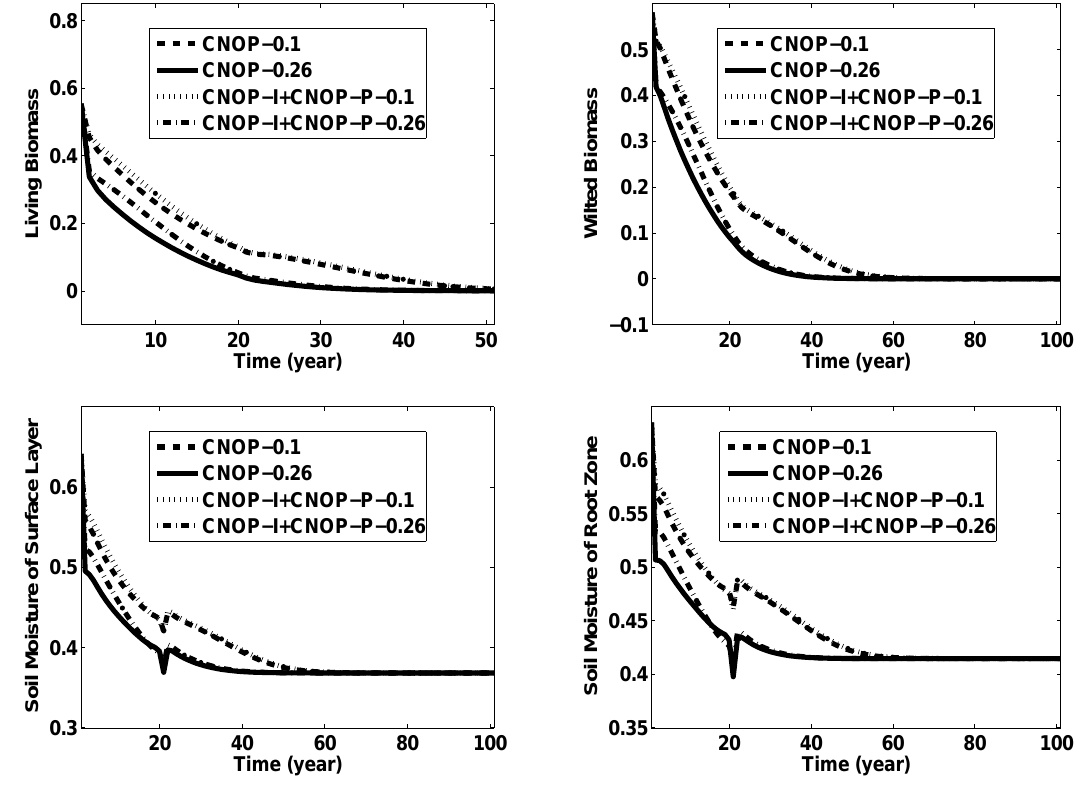
Fig. 4. Same as in Fig. 3, but for δ 2 = 0 . 35. The living biomass (top left), the wilted biomass (top right), the soil moisture of surface layer (bottom left), and the soil moisture of root zone (bottom right).